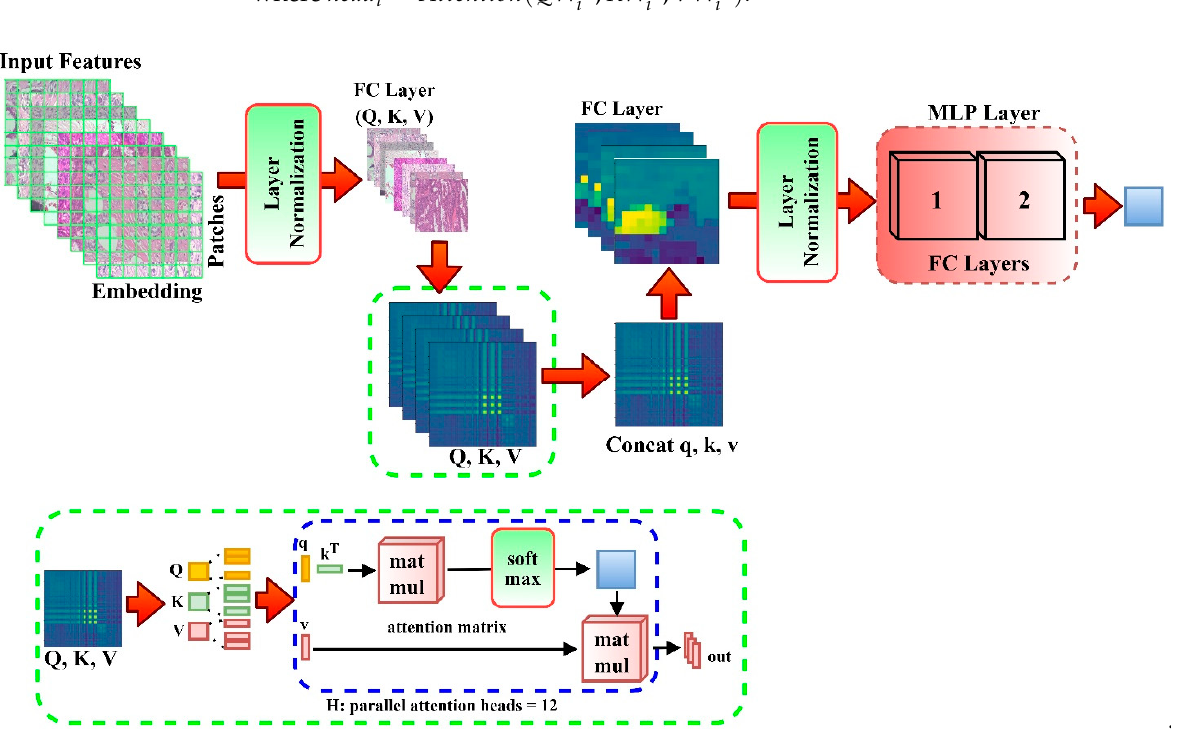
Figure 5. Visualization of DEEP_Pach architecture.